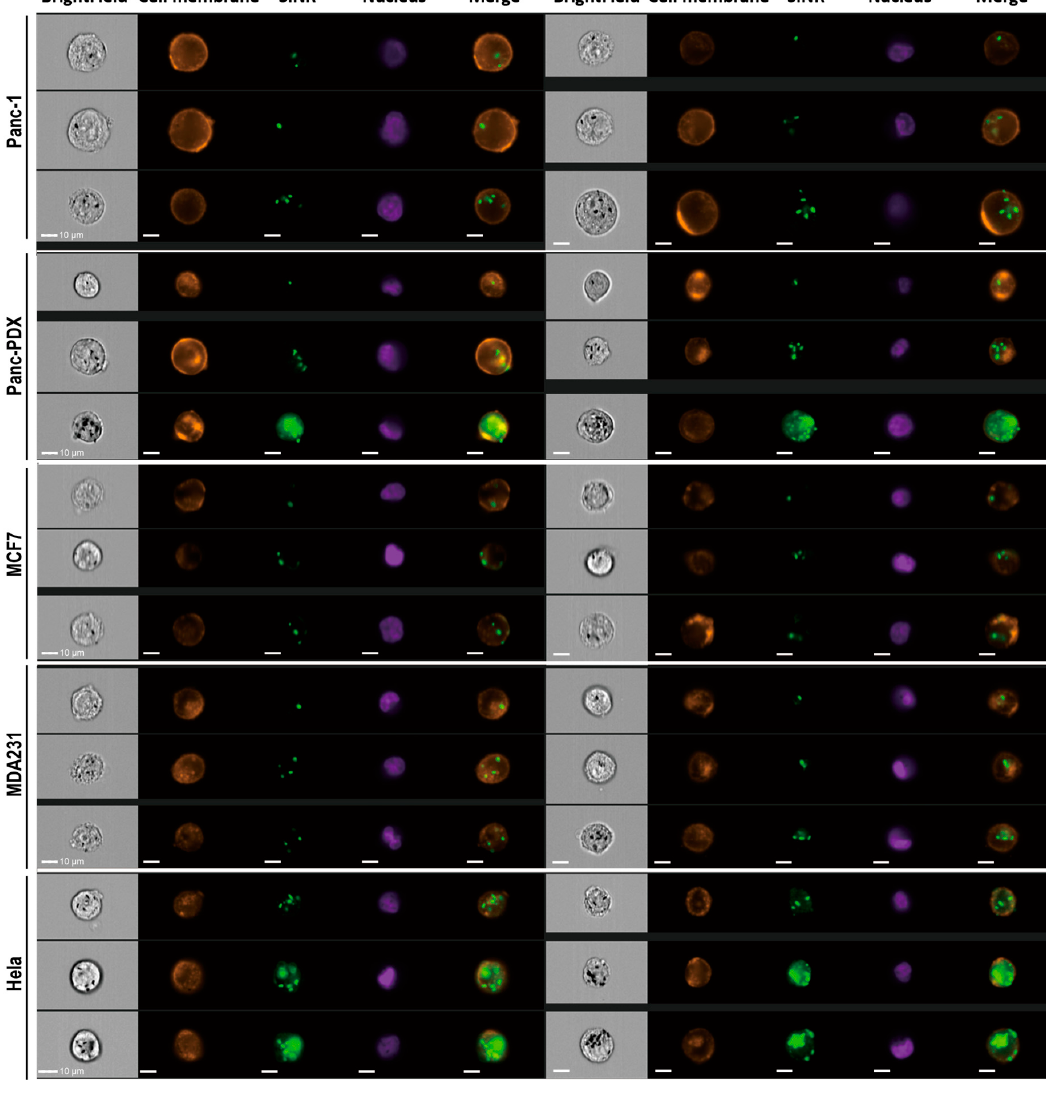
Figure 5. Imaging cytometry analysis of the five types of cells coated on M ‐ size SiNRs, including the Panc ‐ 1 membrane protein. Six cytometry images from the indicated cell lines represent the morphological and fluorescence features of SiNR uptake. The SiNR can be observed in both bright field and FAM (green) channels. Hoechst (purple) indicates the cell nucleus for the cytometer. Alexa ‐ 594 (orange) conjected WGA staining shows the cell membrane. Cell membrane/SiNR merged channel indicates the location of the SiNR inside the cell. The images are as follows: bright field, cell membrane, SiNR, nucleus, and merge of cell membrane and SiNR. Scale bar represents 10 μ m.